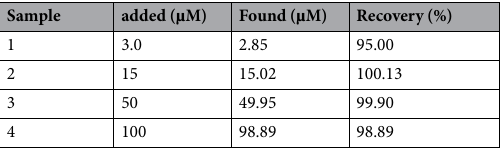
Sample added ( µ M)